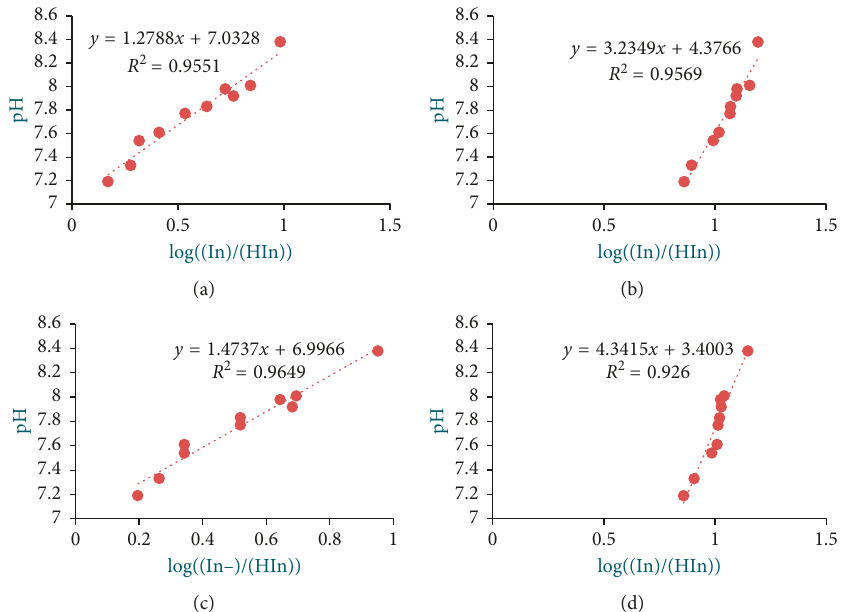
In / HIn for each flower extract and methyl orange: (a) Bauhinia purpurea , (b) Impatiens balsamina , (c) [ ] [ ] −